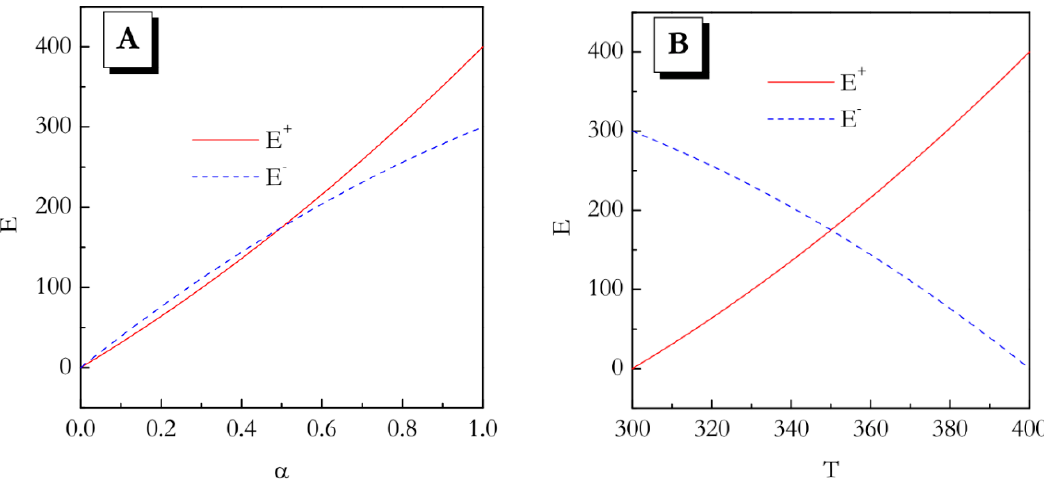
Figure 1. Schematic presentation of the E vs α ( A ) and E vs T ( B ) dependences for heating and cooling based on Equations (1–7).